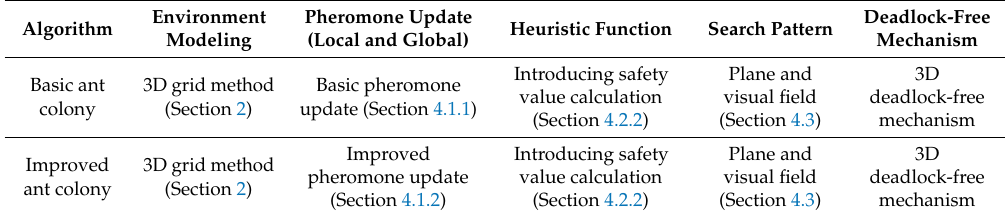
Table 1. Designs of the basic ant colony algorithm and the improved ant colony algorithm.